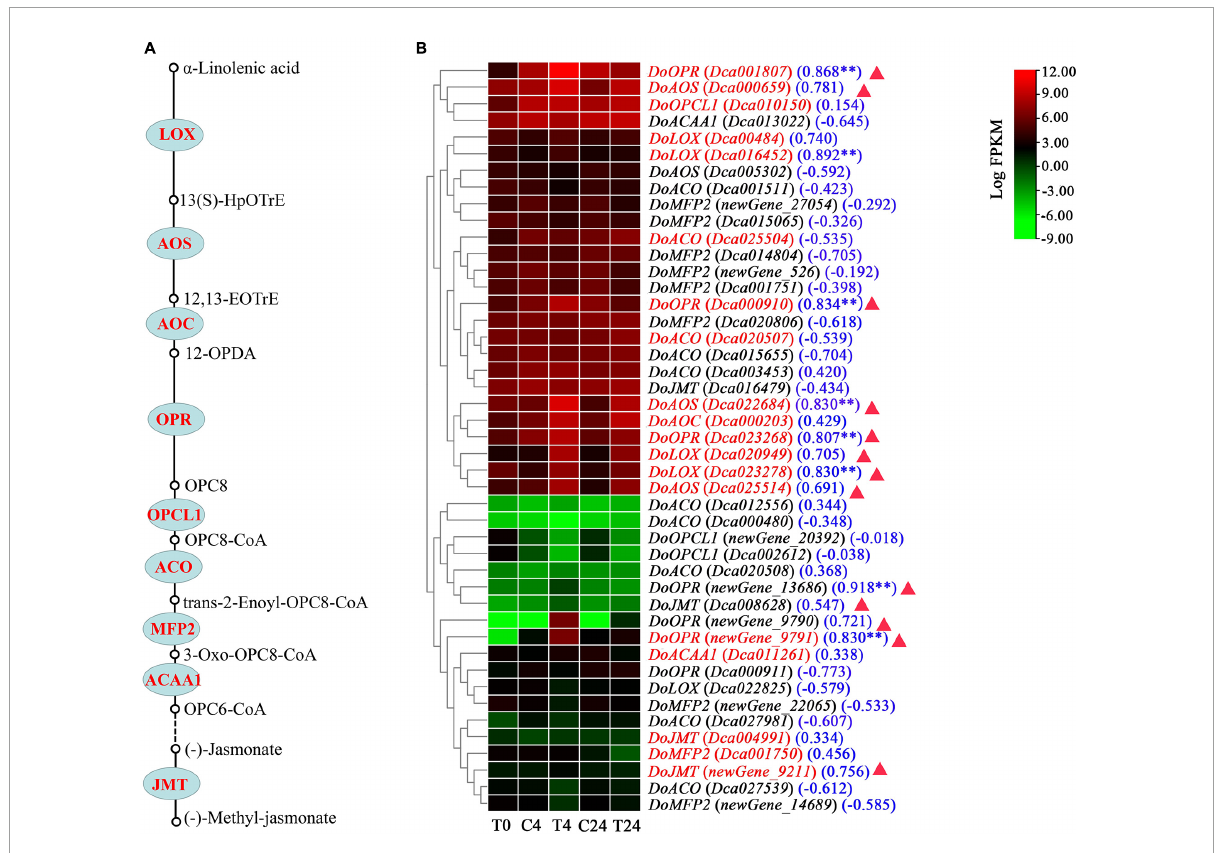
FIGURE8 Expression pattern analysis of genes involved in JA biosynthesis in D. officinale PLBs under the precursor and MeJA treatment. (A) JA biosynthesis pathway. The enzymes are marked in red, indicating that genes encoding the enzymes were differentially expressed in the C4 vs. T4 or C24 vs. T24 groups. (B) Heat map of genes associated with JA biosynthesis. The genes marked in red in the heat map indicates the DEGs identified from the C4 vs. T4 or C24 vs. T24 groups. Blue numbers in brackets represent the correlation coefficient which analyzed between alkaloid content and JA biosynthesis-related genes. ∗∗ p < 0.01 and | r | > 0.8. The red triangle indicates that the gene was found in the brown